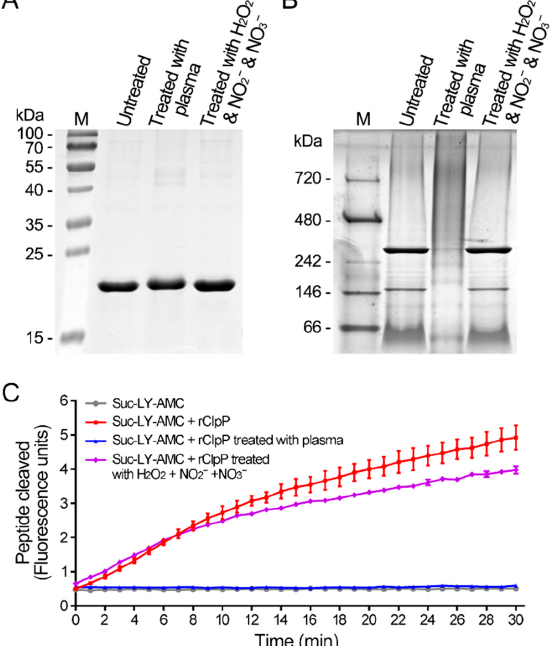
Figure 5. Inactivation of SaClpP by plasma treatment in vitro. ( A ) The plasma-treated, H 2 O 2 + NO 2 − + NO 3 − -treated, and untreated SaClpP proteins separated by SDS-PAGE. ( B ) The plasma-treated, H 2 O 2 + NO 2 − + NO 3 − -treated, and untreated SaClpP proteins separated by blue native PAGE. The SDS-PAGE or blue native PAGE was stained with Coomassie Brilliant Blue R-250. M, molecular weight standards with molecular weights indicated. ( C ) Peptidase activity of SaClpP proteins. The time courses of hydrolysis of the fluorogenic peptide N-succinyl-Leu-Tyr-7-amido-4-methylcoumarin by the plasma-treated, H 2 O 2 + NO 2 − + NO 3 − treated, and untreated SaClpP proteins at 37 °C were measured. Error bars represent the standard deviation (SD).